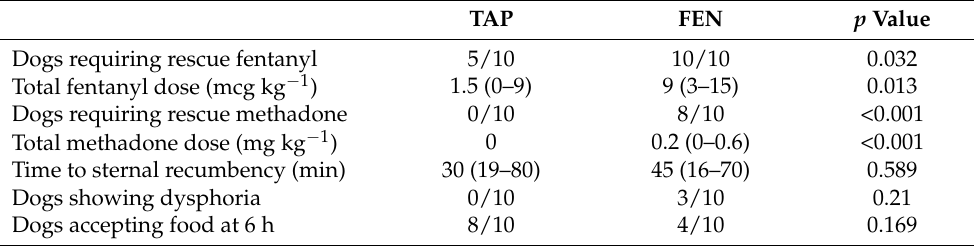
Table 2. Number of dogs requiring rescue fentanyl and methadone, showing post-operative dyspho- ria and eating food 6 h post-extubation: values expressed as number of cases on total number of dogs per group. Total dose of intra-operative rescue fentanyl, post-operative methadone and time to attain sternal recumbency: values expressed as median